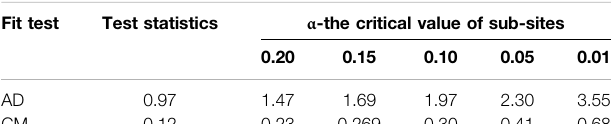
TABLE 4 | Goodness-of- fi t of BMAC.